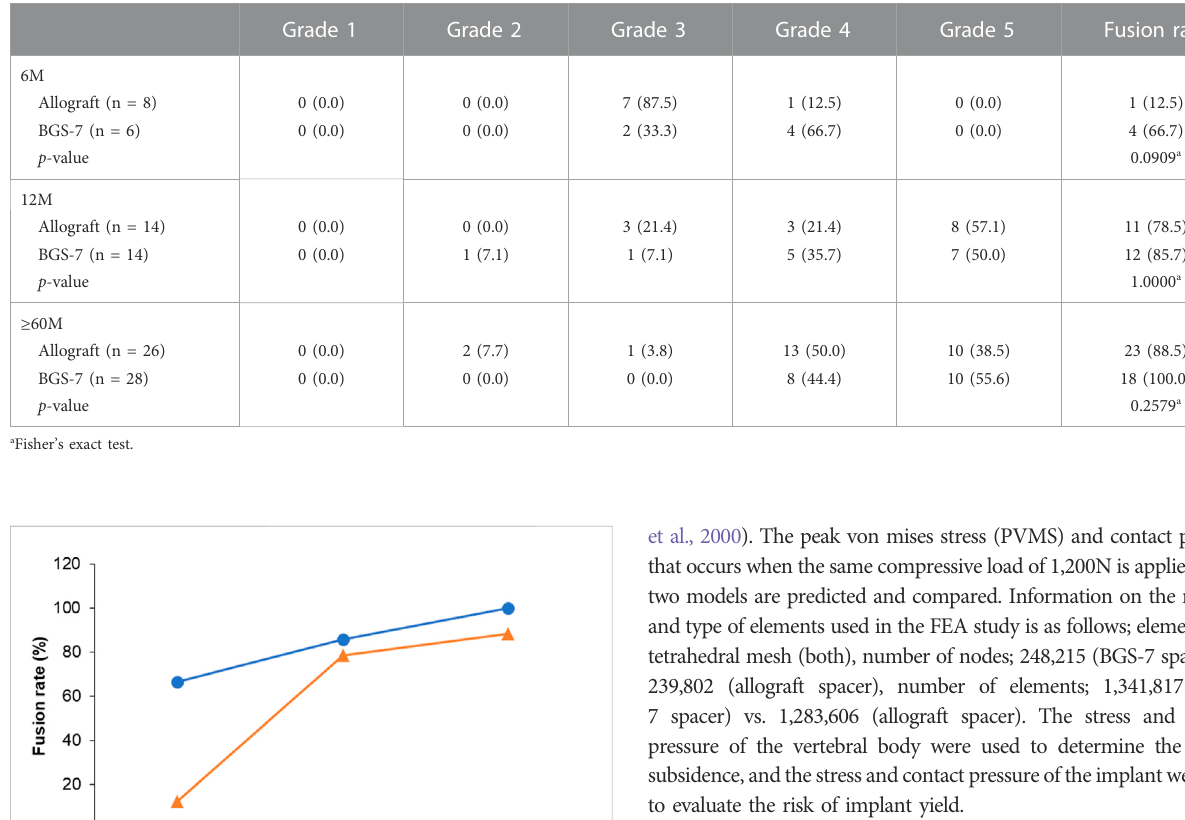
TABLE 5 Results of Brantigan and Steffee fusion grading based on CT scan.